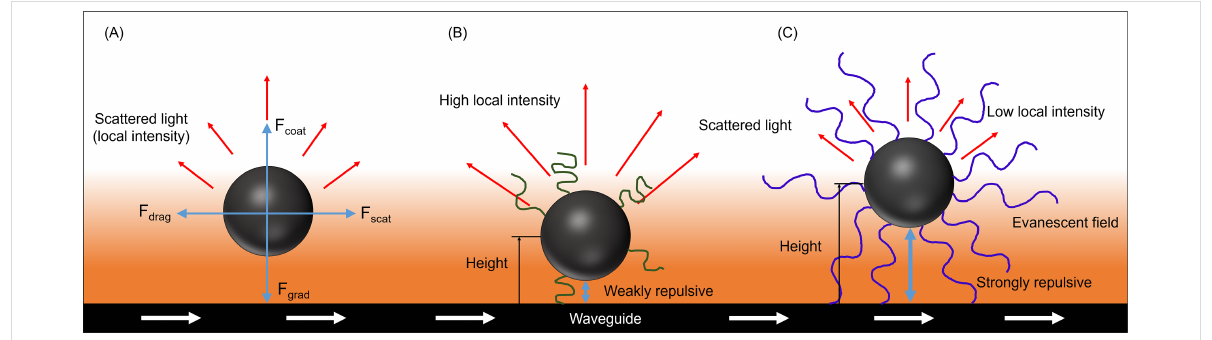
Figure 2: (A) Near-field light scattering with relevant forces acting on the particle. (B, C) Trapped particles with different surface properties move along the waveguide with an equilibrium height determined by the balance of surface repulsion and optical trapping forces.